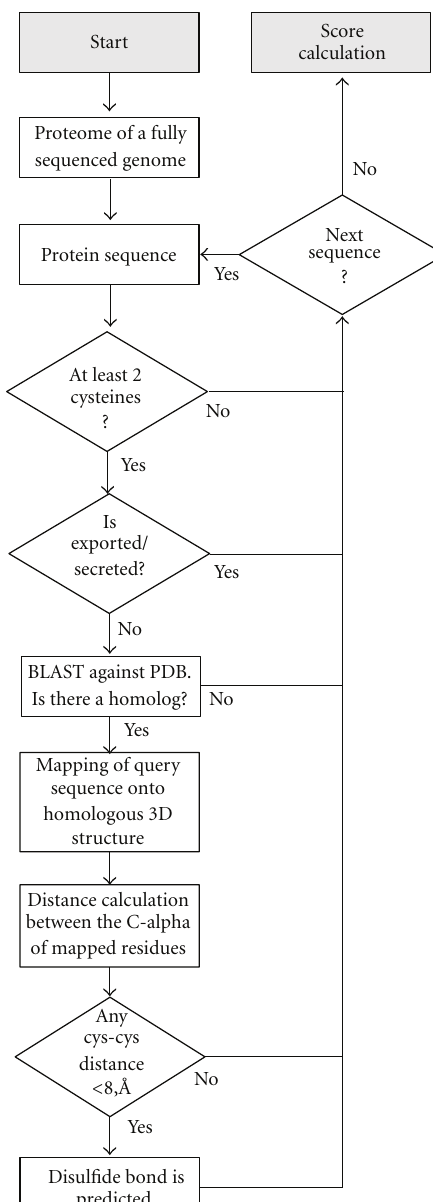
Figure 2: Flowchart illustrating the procedure for mapping genomic sequence data onto known three-dimensional protein structures in order to estimate disulfide abundance. Grey boxes are the starting and ending points of the pipeline, white boxes are processing steps, and diamonds are decisions made subsequent to filtering steps. The procedure loops until all the proteins from a given proteome are